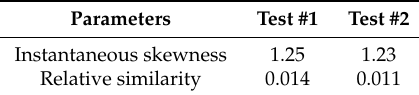
Table 3. CV values for instantaneous skewness and relative similarity.